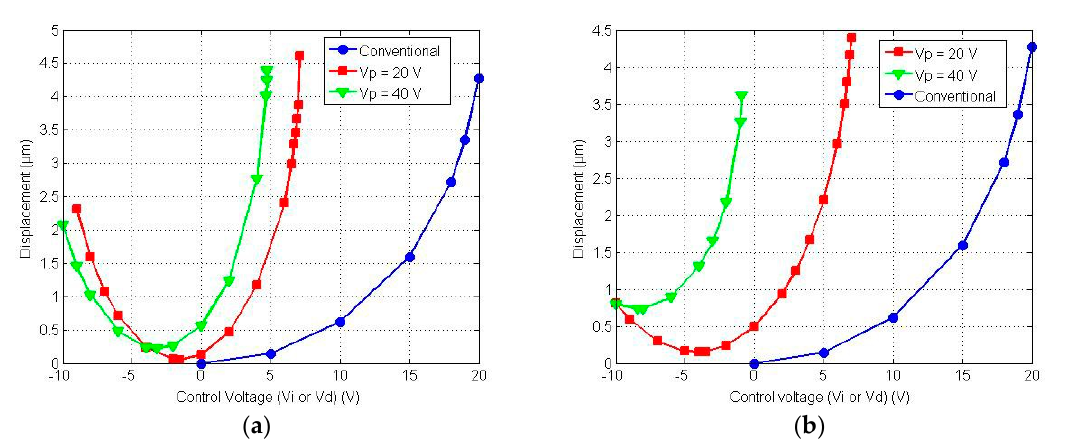
Figure 3. ( a ) Conventional actuator compared to tri-electrode with W E = W S . The blue curve is for the conventional drive mode. The red and green curves are for V p = 20 V and V p = 40 V respectively. ( b ) Conventional actuator compared to tri-electrode with W E = 1/3 W S . The blue curve is for the conventional drive mode. The red and green curves are for V p = 20 V and V p = 40 V